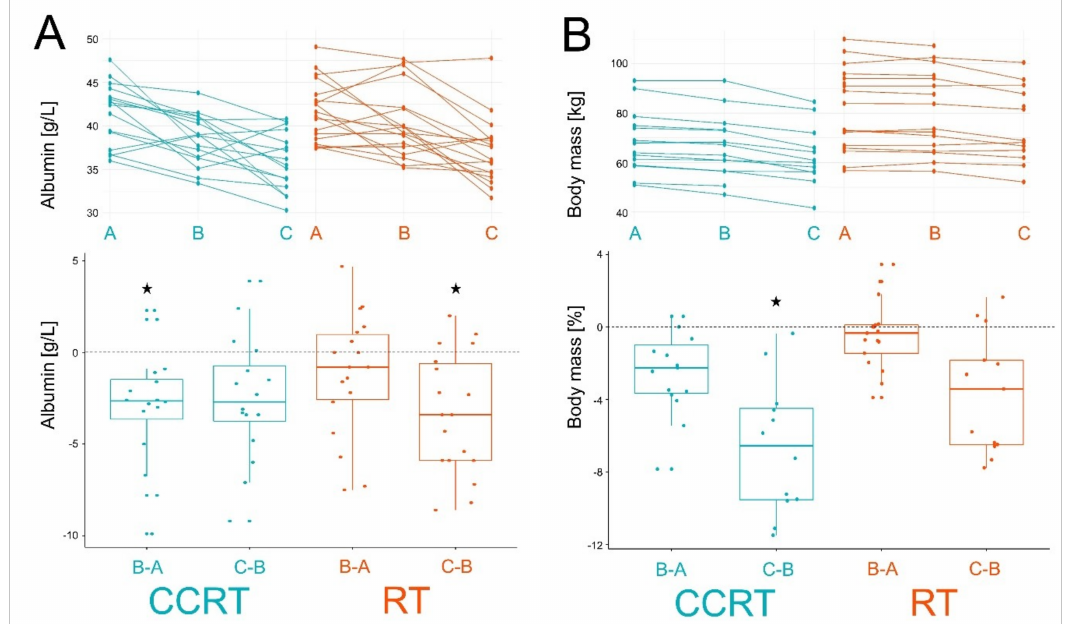
Figure 5. Treatment-related changes in serum albumin panel ( A ) and body mass panel ( B ). Depicted are time courses of individual levels (upper graphs; samples A, B, and C) and di ff erences between consecutive samples (bottom graphs; changes B-A and C-B). Boxplots show minimum, lower quartile, median, upper quartile, and maximum values; dots represent individual di ff erences; significant change (FDR < 0.05) is marked with asterisks. CCRT samples are marked in green and RT samples are marked in orange.